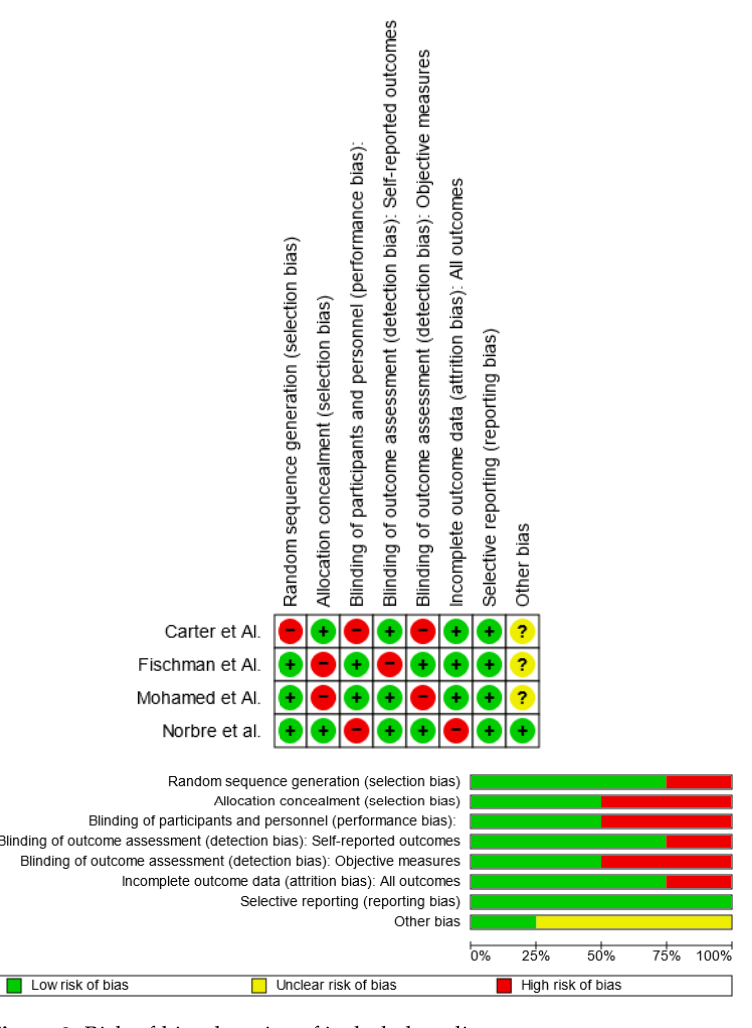
Figure 2. Risk-of-bias domains of included studies.